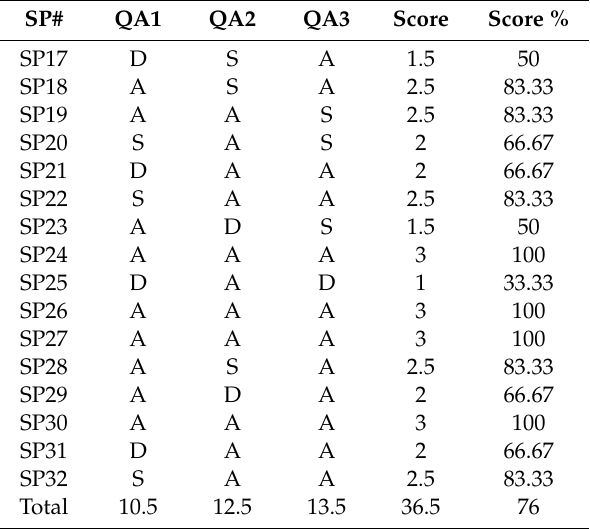
Table 7. Quality assessment of selected research papers on machine